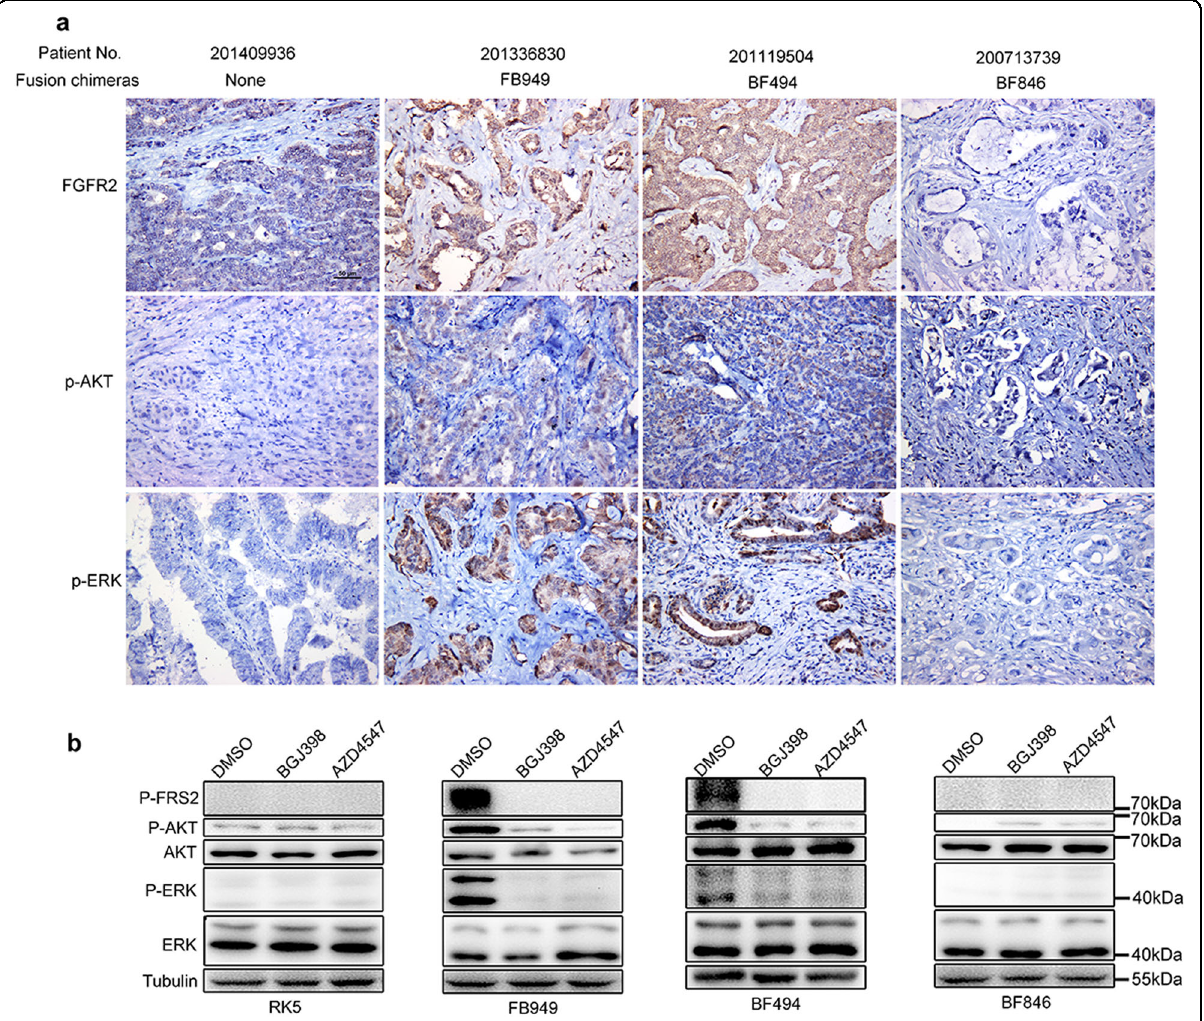
Fig. 6 FGFR2 -selective SMKIs suppressing the activation of FGFR2 downstream pathway in RBE cells harboring sub-classical or classical chimeras. Representative images of FGFR2, p-AKT, and p-ERK immunostaining in tumor specimens harboring different FGFR2 fusion chimeras are shown ( a ). Tumors harboring classical (FB949) or sub-classical (BF494) fusions showed high-expression of FGFR2 and high phosphorylation of AKT and ERK. Western blotting showing signaling inhibition upon BGJ398 and AZD4547 treatment ( b ). Phosphorylation of FRS2, AKT, and ERK was detected in RBE cells expressing FB949, BF494, BF846, or vector